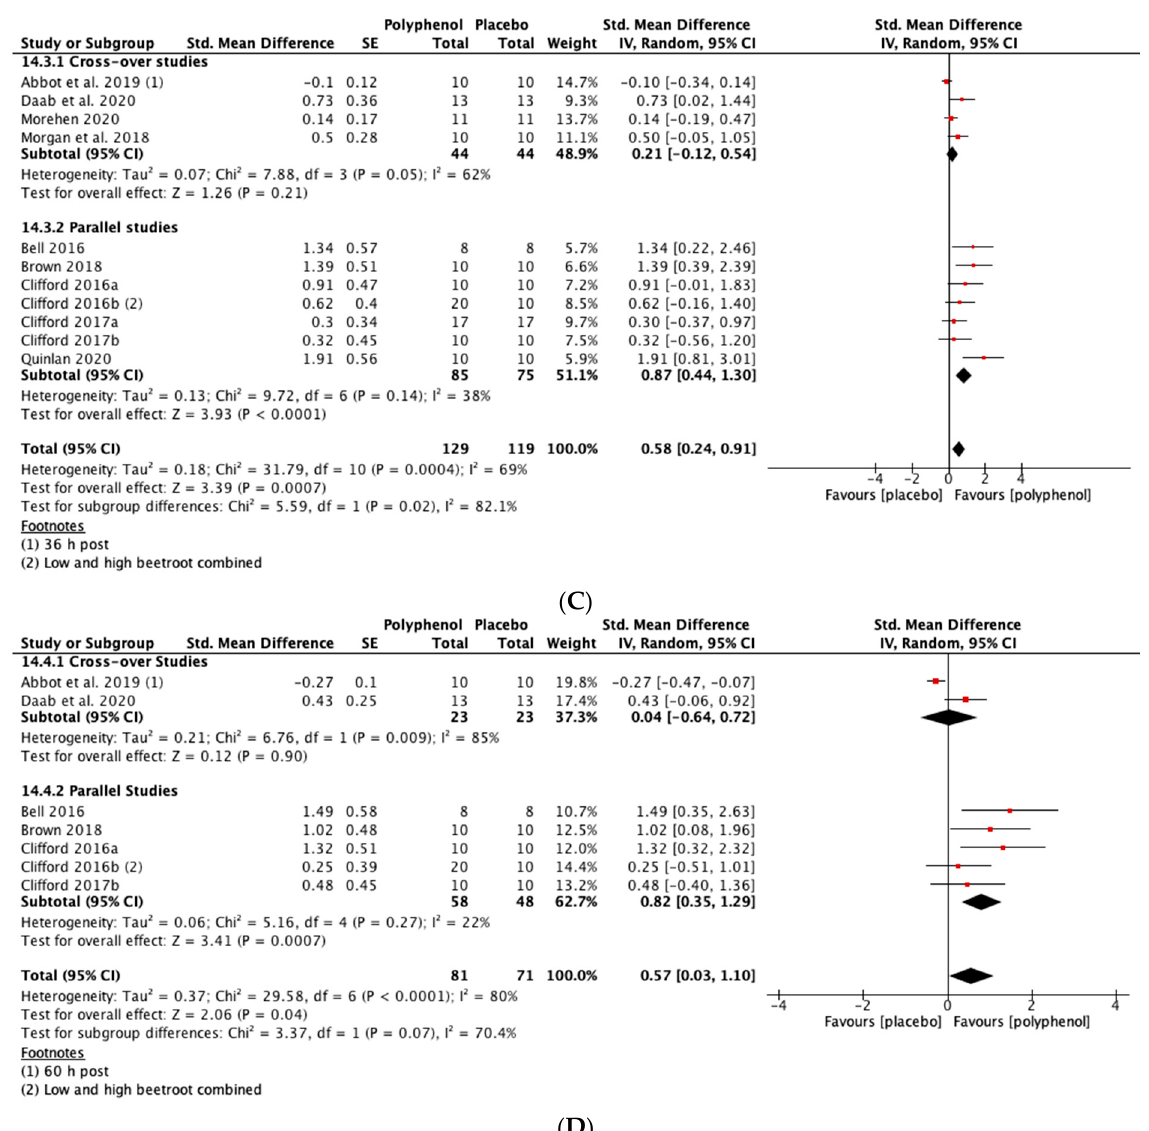
Figure 5. Effect of polyphenol-rich foods, juices and concentrates on recovery of countermovement jump height ( A ) immediately post-exercise; ( B ) 24 h; ( C ) 48 h; ( D ) 72 h.